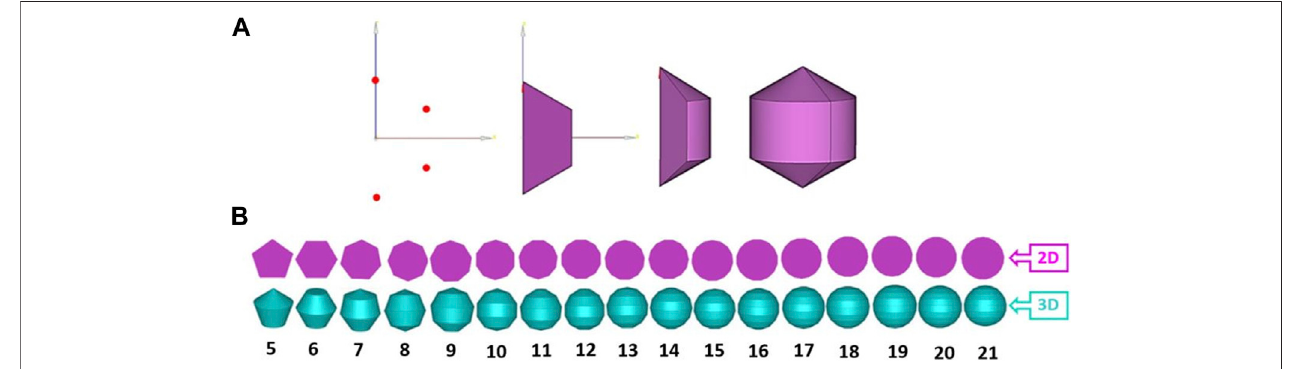
FIGURE 3 | (A) The steps of generating a 3D regular hexagon. In the fi rst step one half of a regular polygon is de fi ned based on the coordinates of its vertices. This half-polygon is then rotated around one of its symmetry axes to form a 3D, regular, axis-symmetric particle; (B) 2D regular polygons and their corresponding 3D regular particles (for side numbers ranging from 5 to 21).